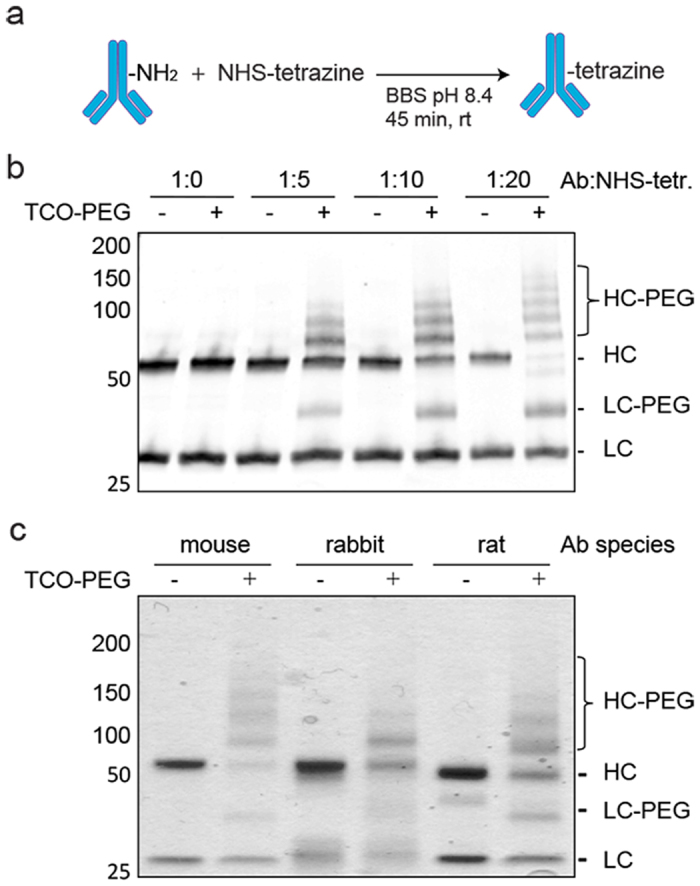
Optimization of antibody functionalization with NHS-PEG4-tetrazine (Figs 3,1).(a) Reaction conditions of antibody functionalization with tetrazine via NHS chemistry. (b) Western blot with ratio series of mouse (anti-TGM1) antibody: NHS-tetrazine (Figs 3,1), and conjugation with TCO-PEG5000. (c) Coommassie staining of SDS-PAGE with mouse (anti-TGM1), rabbit (IgG) or rat (Ago2) antibody functionalized using a 5-fold excess of NHS-tetrazine (Figs 3,1) and conjugation with TCO- PEG5000.